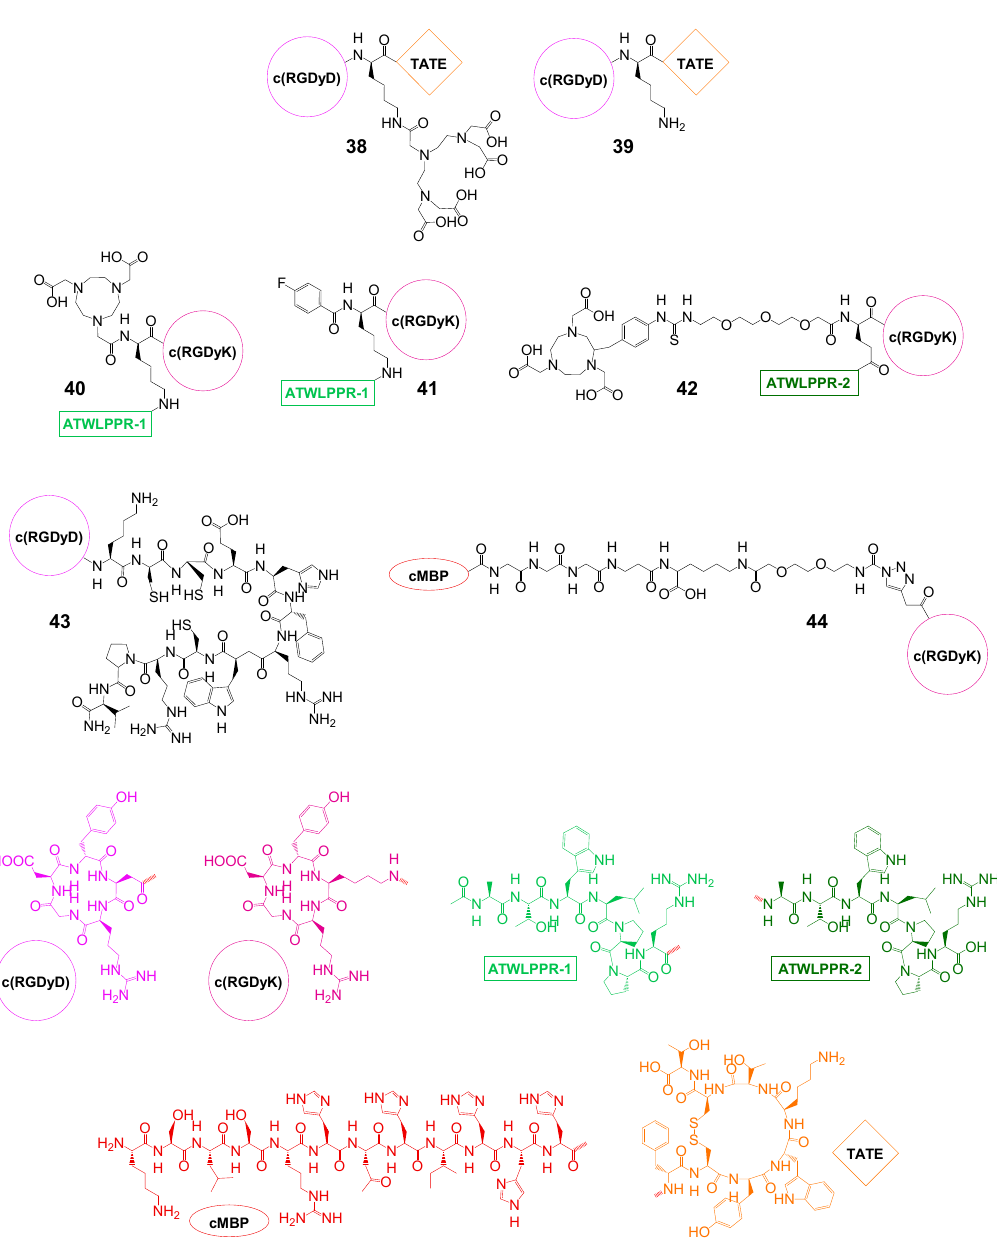
Figure 10. Structures of further bispecific radioligands comprising an α v β 3 integrin-binding peptide developed for imaging or therapy of different malignancies.